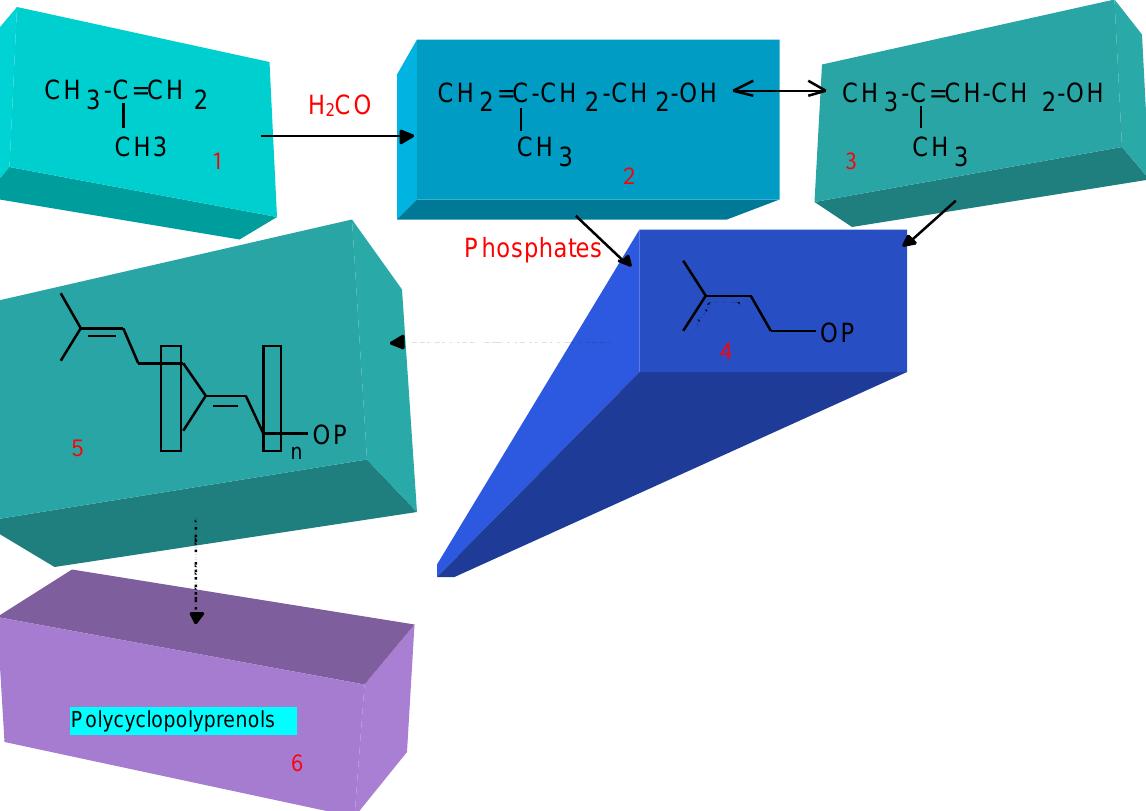
Figure 1. TIC chromatograms (total abundance of ions recorded) of the chloroform extract from raw reaction products plotted versus retention time.